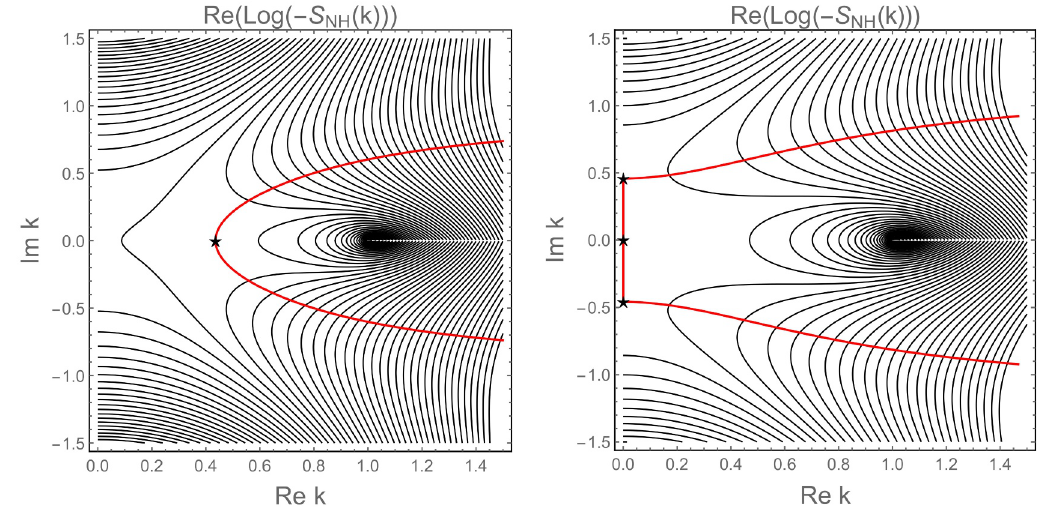
Figure 12 . Relevant steepest descent contours to perform the large- n saddle point analysis (solid red), along with the adjacent saddles (black stars), for s = 1 . Left: t = 0 . 9 . Right: t = 1 . 1 .